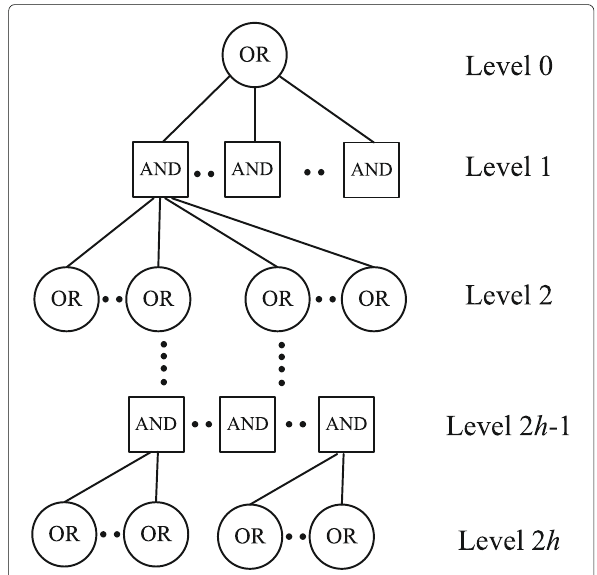
Fig. 3 Example of conventional AND-OR trees. The OR nodes indicate input symbols, and the AND nodes indicate output symbols. The probability that the root node is evaluated as 0 after h iterations indicates the symbol error rate in this rateless decoding